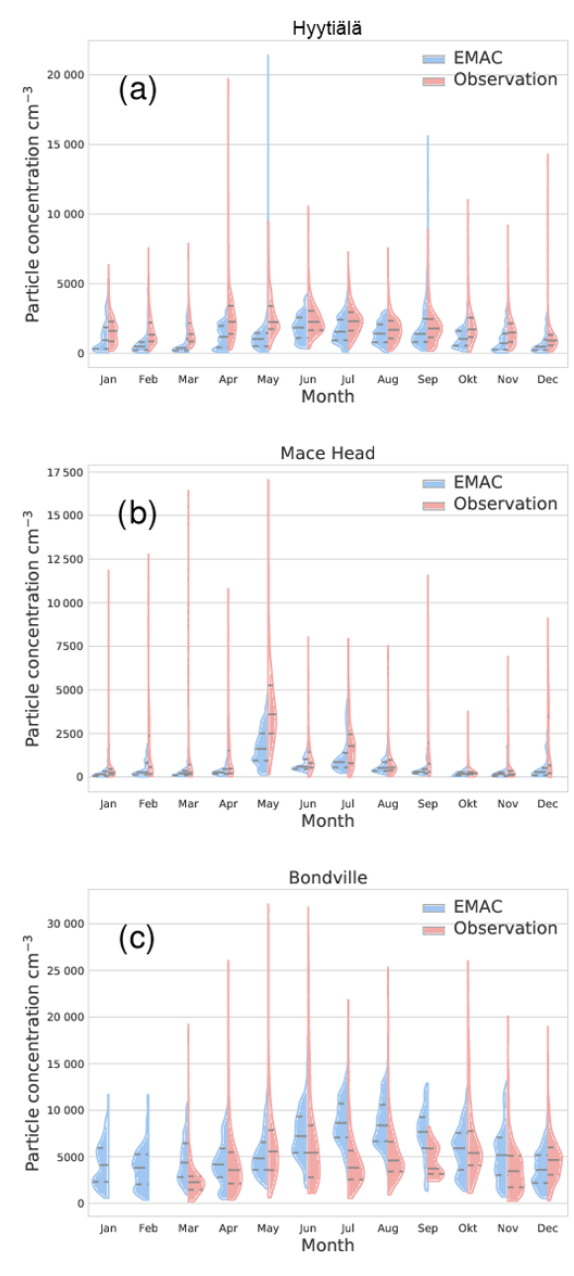
Figure 8. Comparison of EMAC-simulated aerosol particle number concentrations, including the parameterisations of Riccobono et al. (2014), Dunne et al. (2016) and Kirkby et al. (2016), with atmo- spheric observations for three stations and the year 2008. The area shows an estimate of the monthly distribution of values for EMAC simulation (left, blue) and observation (right, red). The central verti- cal line within each area gives the monthly median for each month; the upper and lower lines are first and third quantiles. The station names are above each panel; Table 2 contains the coordinates for each station. Figures for all stations are in the